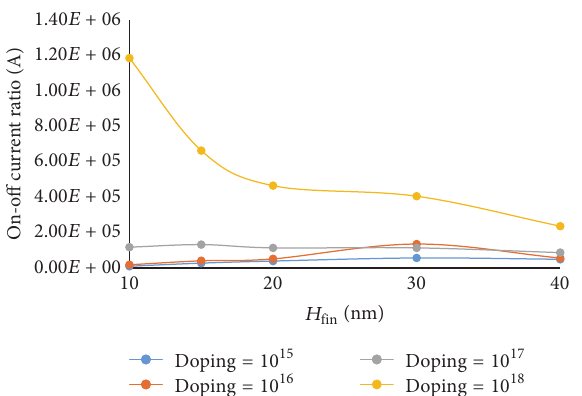
Figure 6: Variation of on-off current ratio with fin height for different doping concentration at 1nm oxide thickness.